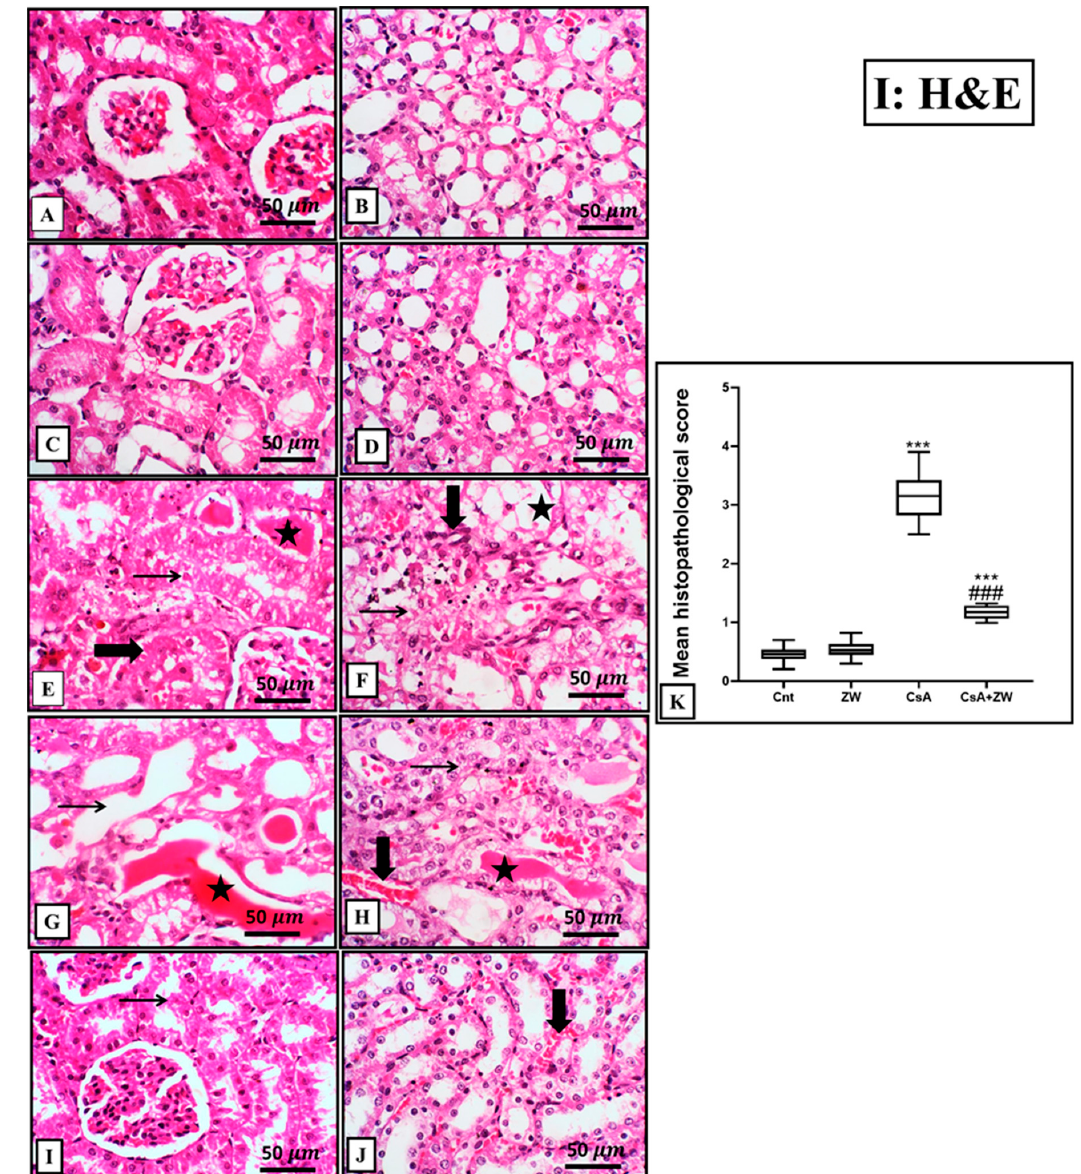
Figure 1. Representative photomicrograph of renal tissues from the control and experimental groups stained with H&E. ( A , C ) The control and ZW groups show cortical glomeruli and tubules with normal architecture. ( B , D ) The control and ZW groups show medullary tubules with normal histology. ( E ) The CsA group shows a diffuse loss of cellular detail with hypereosinophilic cytoplasm and nuclear pyknosis, karyorrhexis, and karyolysis (necrosis) (thin arrow), along with swollen, vacuolated cytoplasm with faded nuclei beside intraluminal eosinophilic globules admixed with sloughed tubular epithelial cells, necrotic debris (granular casts) (star), and proliferative glomerular capillaries (thick arrow). ( F ) CsA medullary tubules underwent diffuse medullary tubular necrosis (thin arrow) and vacuolation (star) with focal interstitial fibrosis (thick arrow). ( G ) The CsA group shows diffuse necrotic cortical tubules with a large intraluminal hyaline cast. ( H ) Medullary tubular sloughing (thin arrow) and intraluminal hyaline cast (star) with interstitial congestion (thick arrow). ( I ) The CsA + ZW group displays occasional individual tubular necrosis (thin arrow). ( J ) The CsA + ZW group exhibits diffuse minimal-to-mild interstitial congestion (thick arrow). ( K ) Histogram of the percentage area of the histological score. *** p < 0.001 vs. control ; ### p < 0.001 vs. CsA. Image magnification = 400 × ; scale bar = 50 µ